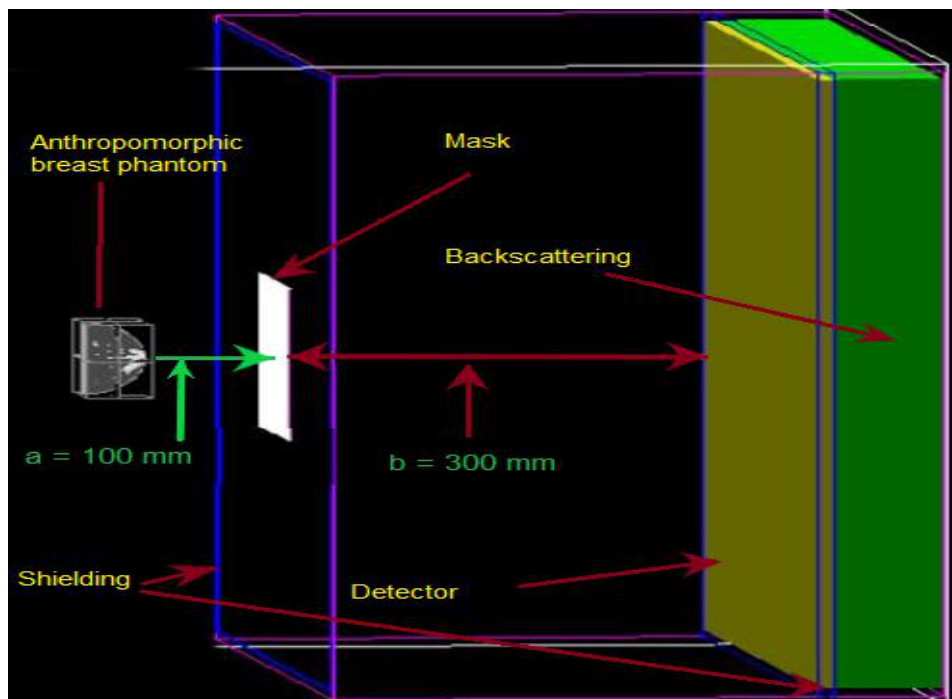
Figure 2. Visualization of simulated geometrical structure using GATE.